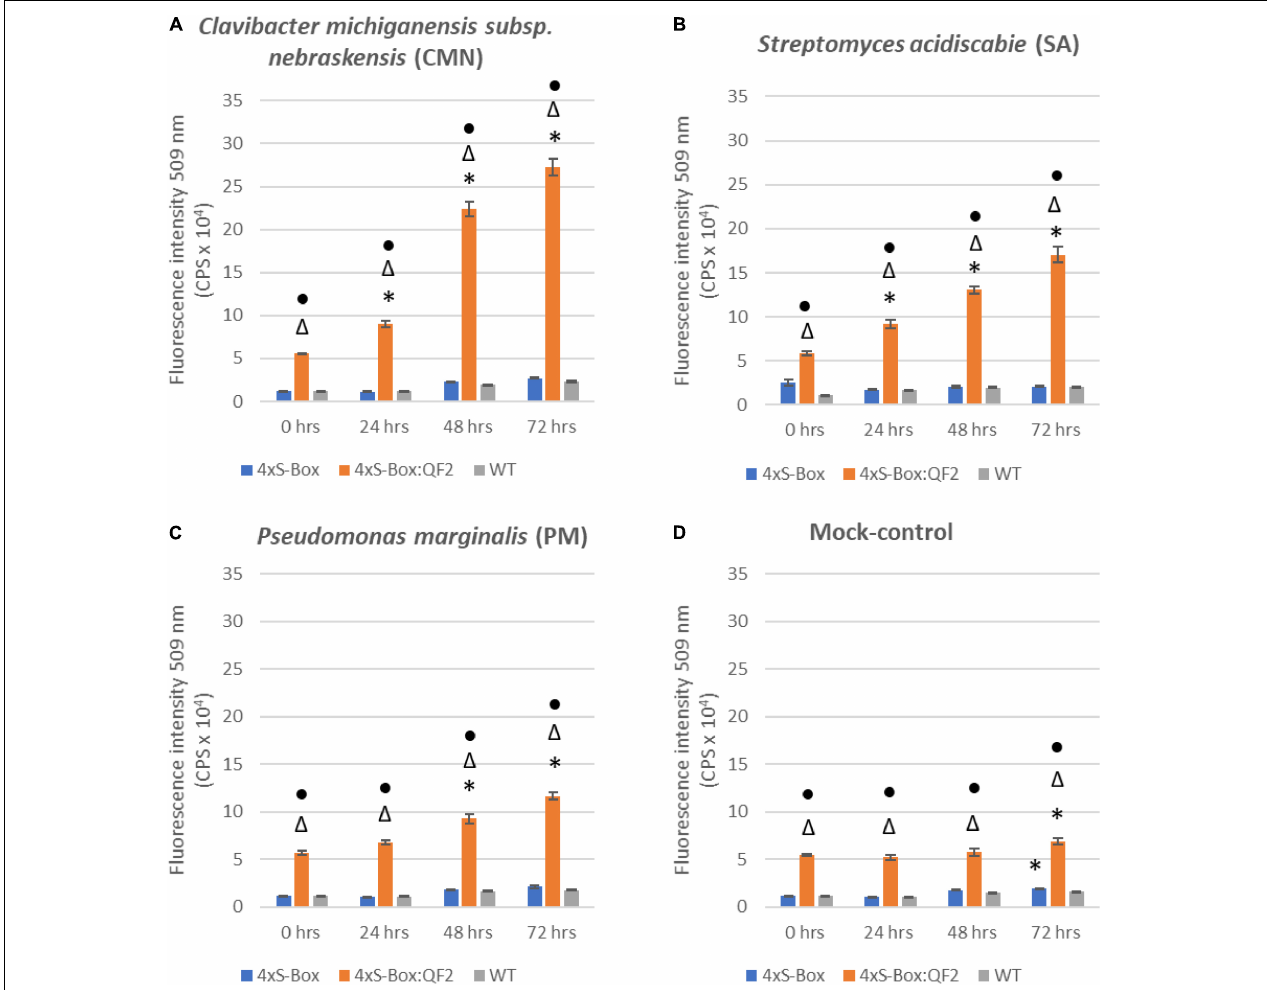
FIGURE 2 | Time course spectro-fluorescence analysis of enhanced pathogen phytosensor. Spectral data represent mEmerald emission measured at 509 nm emission obtained with a 475 nm excitation wavelength. mEmerald fluorescence intensity measured for transgenic phytosensor 4xS-Box:QF2 (with Q-system) and 4xS-Box (without Q-system), and WT (wild-type) plants at 0, 24, 48, and 72 h post inoculation with bacterial pathogens: (A) Clavibacter michiganensis subsp. nebraskensis (CMN), (B) Streptomyces acidiscabie (SA), (C) Pseudomonas marginalis (PM), and (D) 10 mM MgCl 2 (mock-control). Plants were infiltrated with a bacterial inoculum of OD 600 = 0.3, corresponding to colony forming units (cfu) of 3 × 10 8 cfu/ml CMN, 3 × 10 8 cfu/ml SA, and 1 × 10 8 cfu/ml PM. Statistically significant differences determined using ANOVA, Tukey HSD post hoc analysis. Significant differences indicated by: ∗ from 0 h (before treatment); (cid:52) from WT; • from 4xS-Box ( p < 0.05). Three independent experiments with three biological replicate plants ( n = 3) per experiment was performed. In total three technical replicate spectral readings were collected on a single leaf for each biological replicate per experiment to account for positional error. Data represent mean ± standard error of 27 spectral